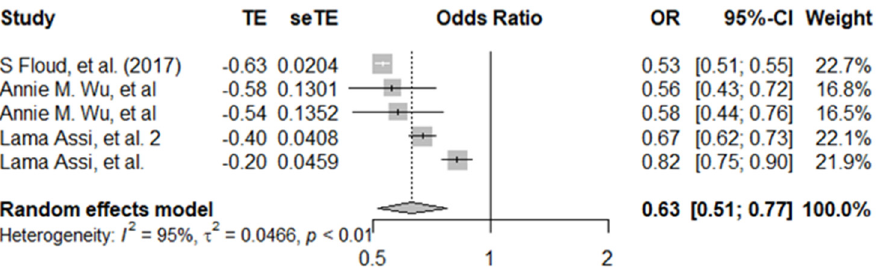
Figure 4. Pooled adjusted odds ratio estimates of breast cancer screening uptake by visual impairment status [9,23,44].